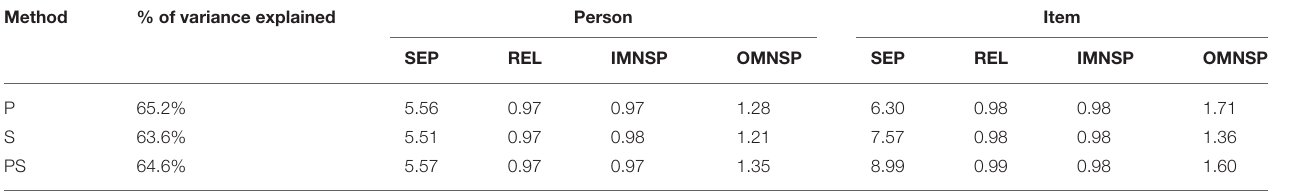
TABLE 5 | Summary of the person separation and item separation values.